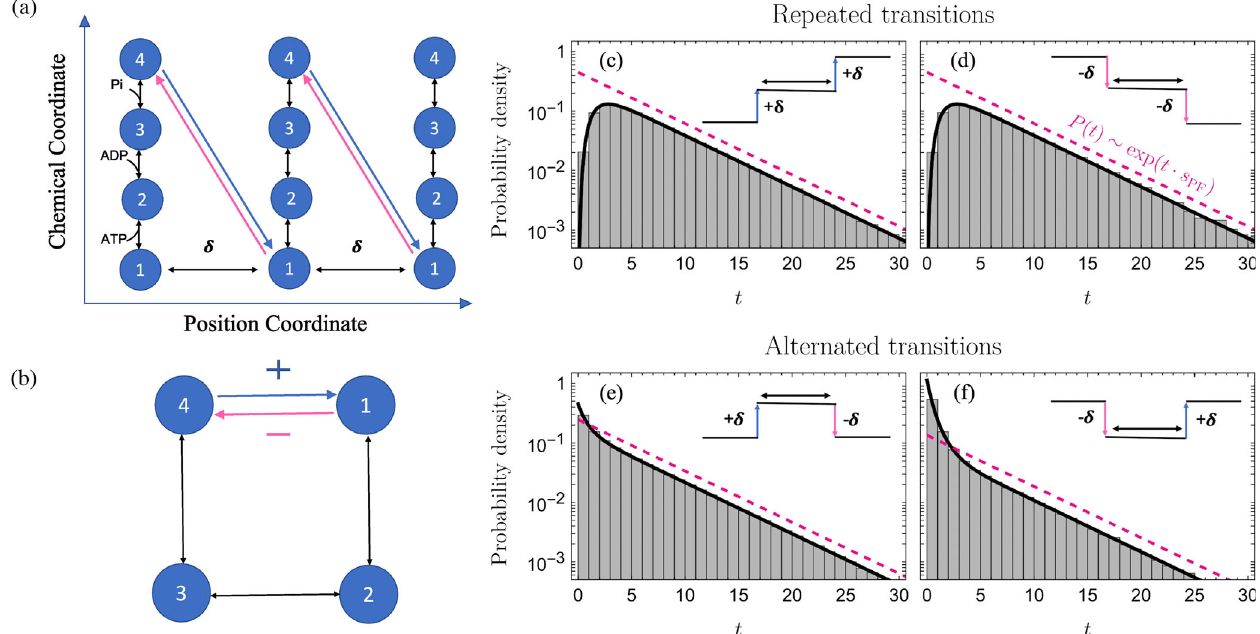
FIG. 2. Illustration of transition statistics in an ATP-driven motion of a molecular machine in which only spatial displacements are visible to an experimental apparatus. Chemical transitions (ATP binding 1 → 2 , ADP release 2 → 3 , and Pi release 3 → 4 ) are hidden from the apparatus. (a,b) Illustration of the model state network, given by a four-state model (b) arranged along a periodic spatial lattice (a) along which the motor moves only when executing the 4 → 1 transition (motion forward þ with step size δ ) or the 1 → 4 transition (motion backward − with step size δ ). (c) – (f) Histograms for the intertransition-time probability densities obtained from Gillespie simulations (bars), and analytical predictions given by Eq. (20). The dashed magenta lines have slope given by the largest eigenvalue of the survival operator S [see Eq. (25)], and the inserted diagrams are illustrations of the displacement of the motor during the respective pair of transitions (see